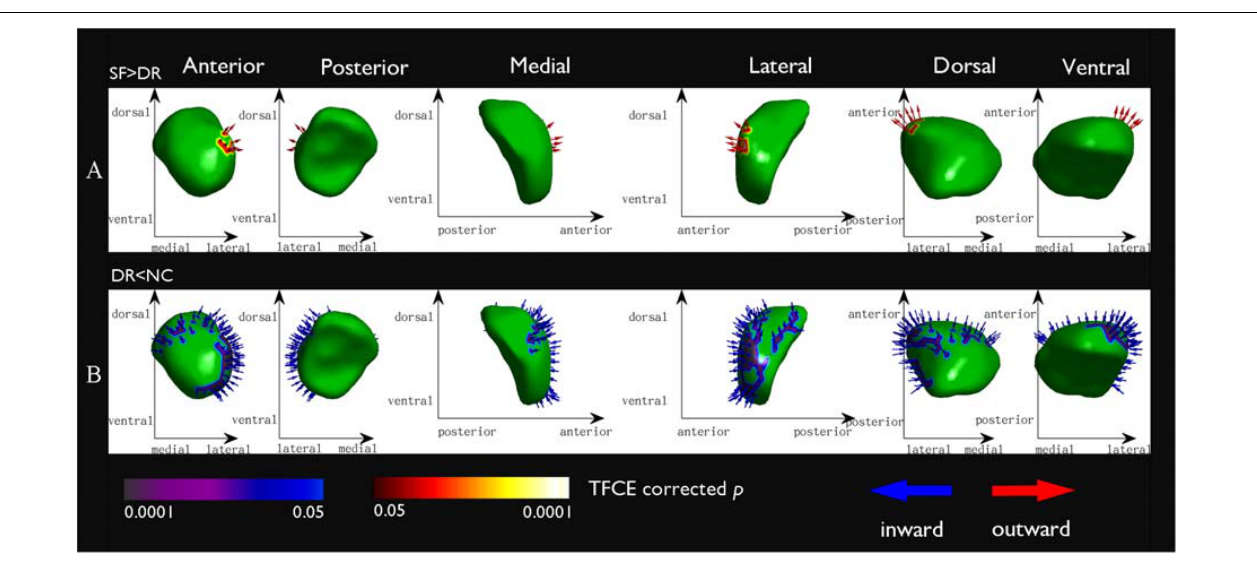
FIGURE 4 | Vertex-based shape analysis results of the comparison between groups at a significance level of p < 0.05 (FWE corrected) and controlling for age and sex. Red arrows point outward (expansion) and blue arrows point inward (atrophy). The x - and y -axes indicate different directions (dorsal, ventral, medial, lateral, anterior, posterior) to show different location information. (A) The seizure free > the drug resistant, the basolateral region of the left amygdala: 172/872 19.72%; (B) the drug resistant < the normal controls, the basolateral region of the left amygdala: 616/911 67.62%. TABLE 3 | Correlation among volume and shape changes of subcortical nuclei along with seizure frequency and IGE duration. Groups DR SF + DR